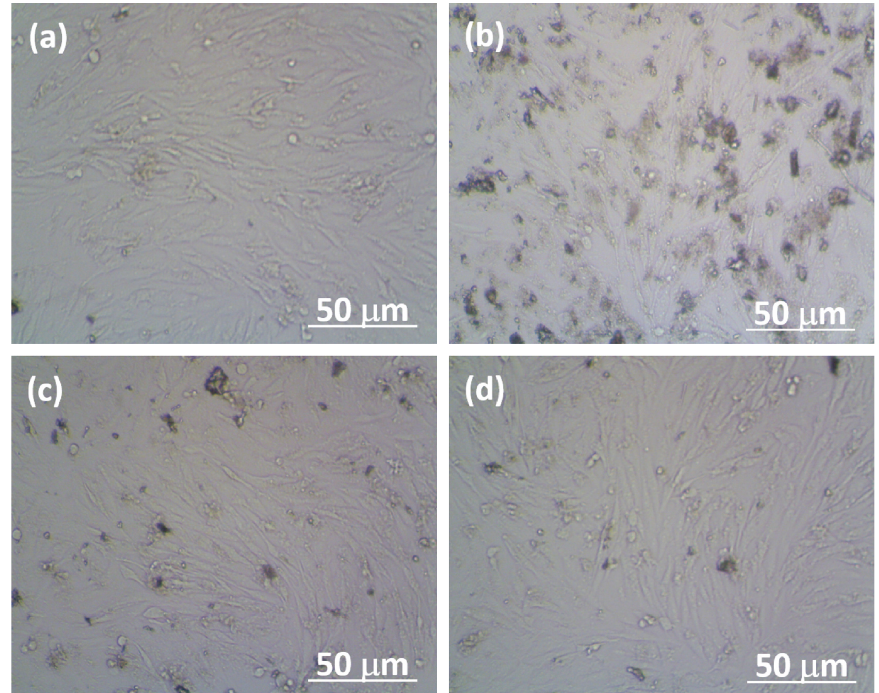
Figure 8: Optical images showing the viability of HOS MG63 cells on HNT-CS-MHA composite coating for (a) control and (b) 1, (c) 4, and (d) 7 days of